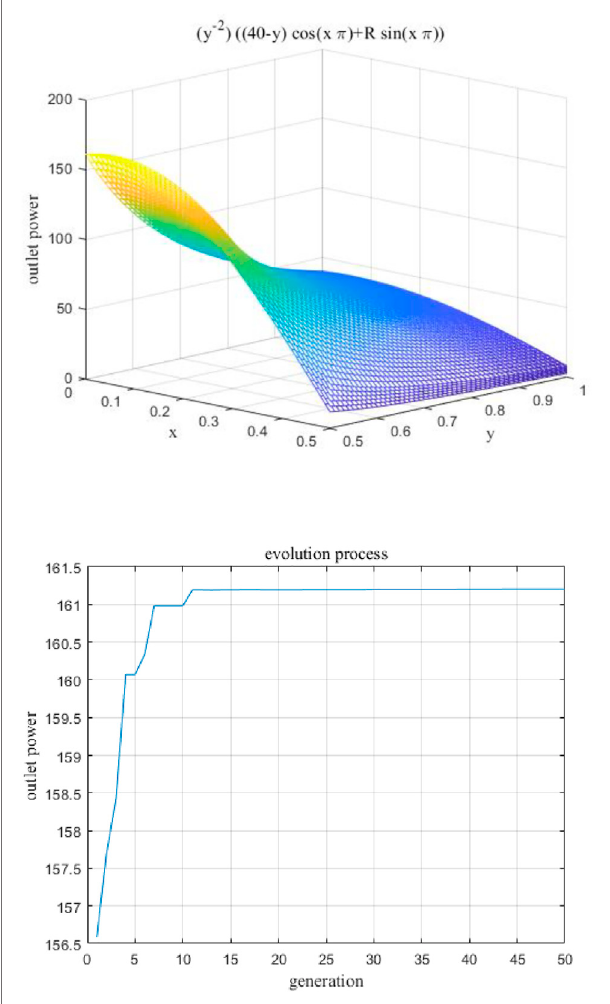
FIGURE 7 | Optimization process diagram based on genetic algorithm. (A) Fitness function. (B) Calculation process of genetic